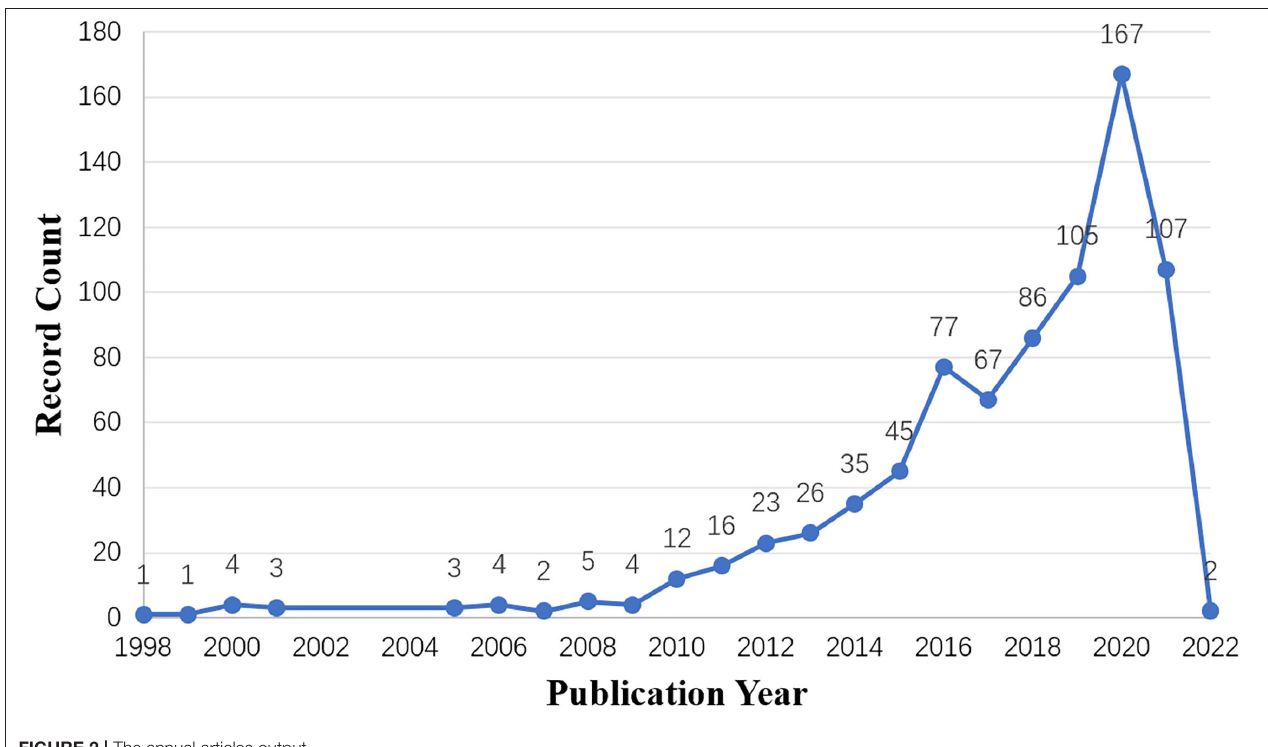
FIGURE 2 | The annual articles output.